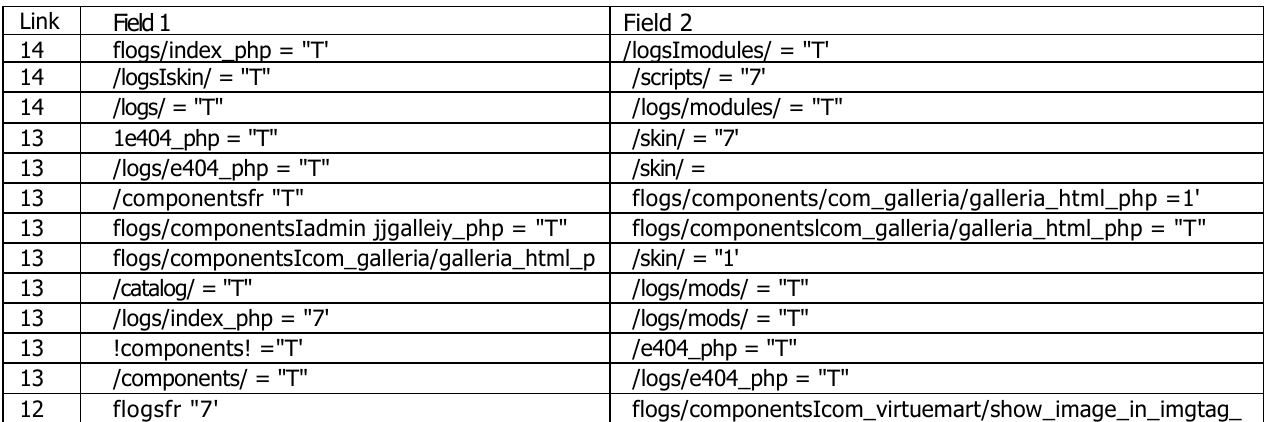
Table 14. Weak links between